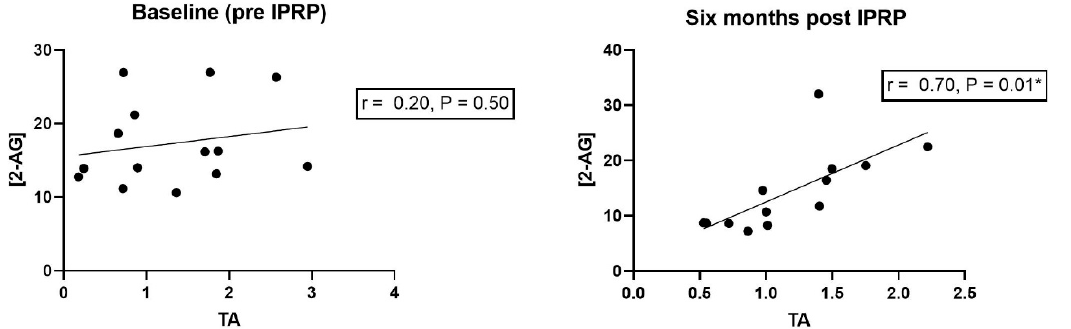
Figure 1. Scatter plots with best fitted regression lines of 2-arachidonoylglycerol (2-AG) and telomerase activity (TA) pre (left panel), and six months post interdisciplinary multimodal erase activity (TA) pre ( left panel), and six months post interdisciplinary multimodal rehabilitation rehabilitation program IPRP (right panel). r = Pearson’s correlation coefficient and * indicate program IPRP ( right panel). r = Pearson’s correlation coefficient and * indicate statistical statistical significance.